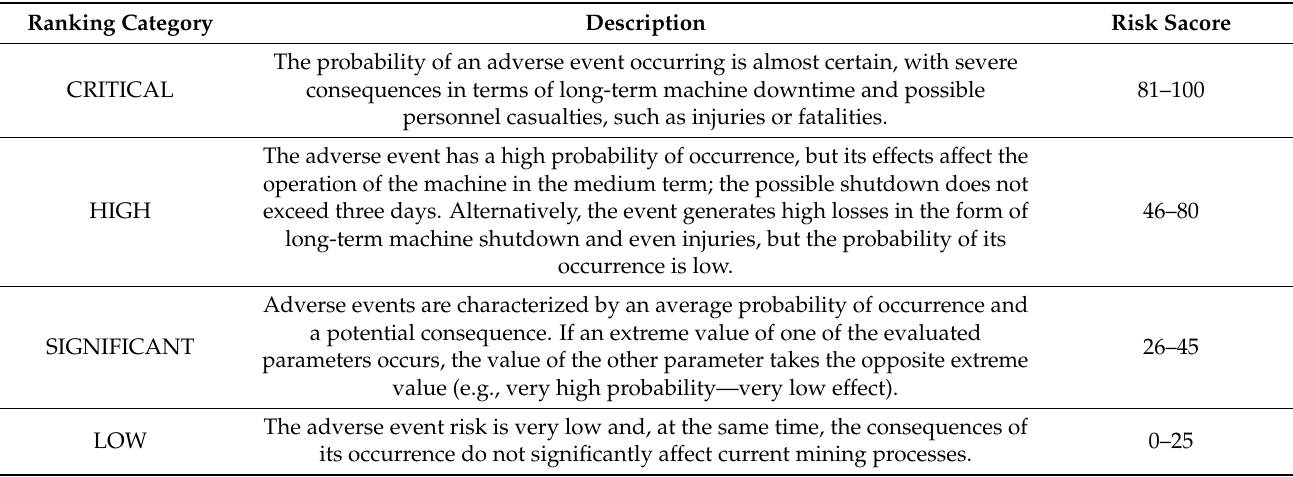
Table 6. Risk levels and